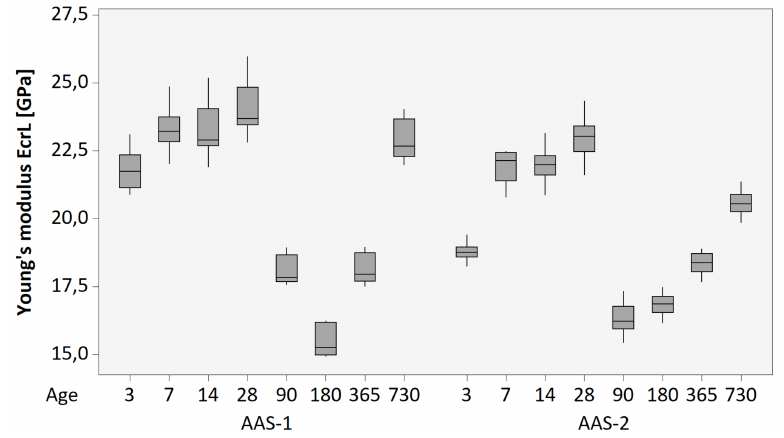
Figure 3. Box plot of the development of the Young’s modulus E